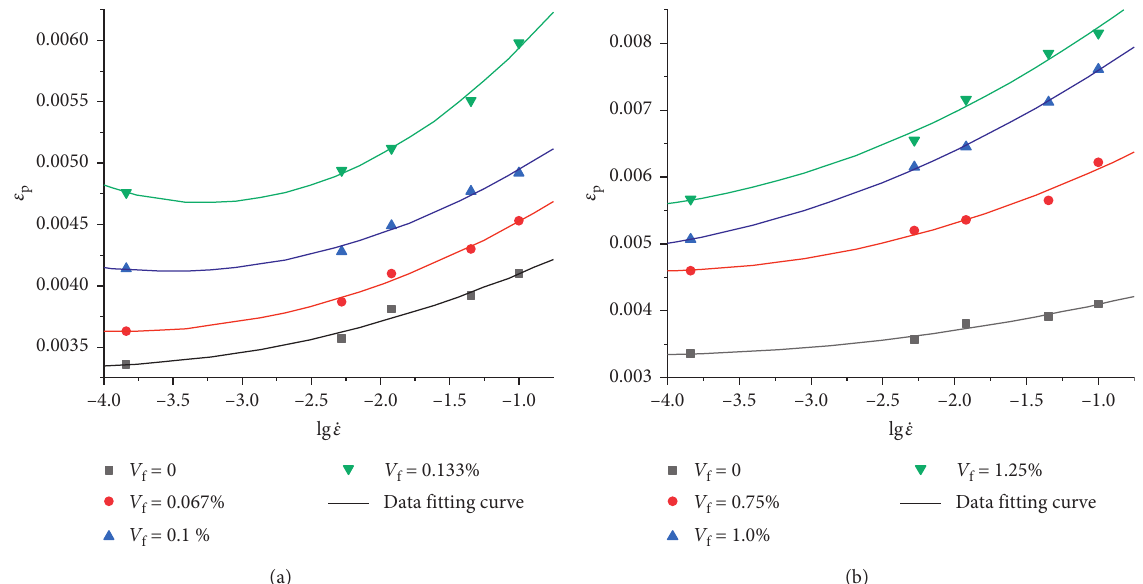
Figure 9: (a) The variation and data fitting of ε